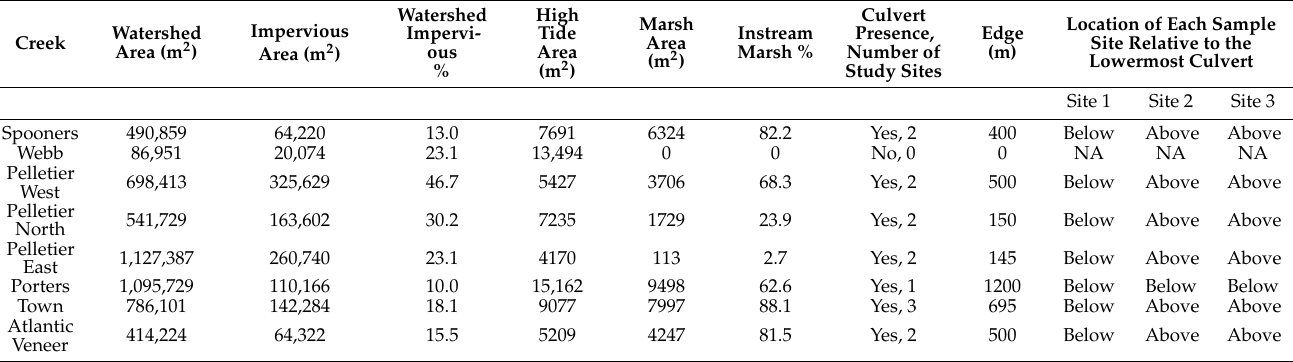
Table 1. Values for creek and watershed habitat and urbanization factors for eight first-order tidal creeks in coastal North Carolina (USA) where juvenile blue crab Callinectes sapidus occupancy dynamics were studied. For each creek, the number of sites with culverts is listed in the third-to-last column. Sites from downriver-to-upriver in each creek are numbered 1–3. Creeks are tabled in order (from west to east) that they appear on the overview map (Figure 1). ‘NA’ = not applicable (no culvert).